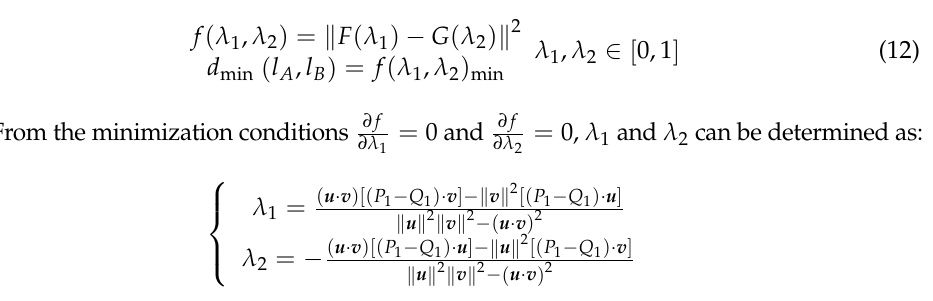
( ) d l l is the minimum distance between the axial segments; and , where A B min r are the radii of the capsule bodies. B Spatial central axis segments A